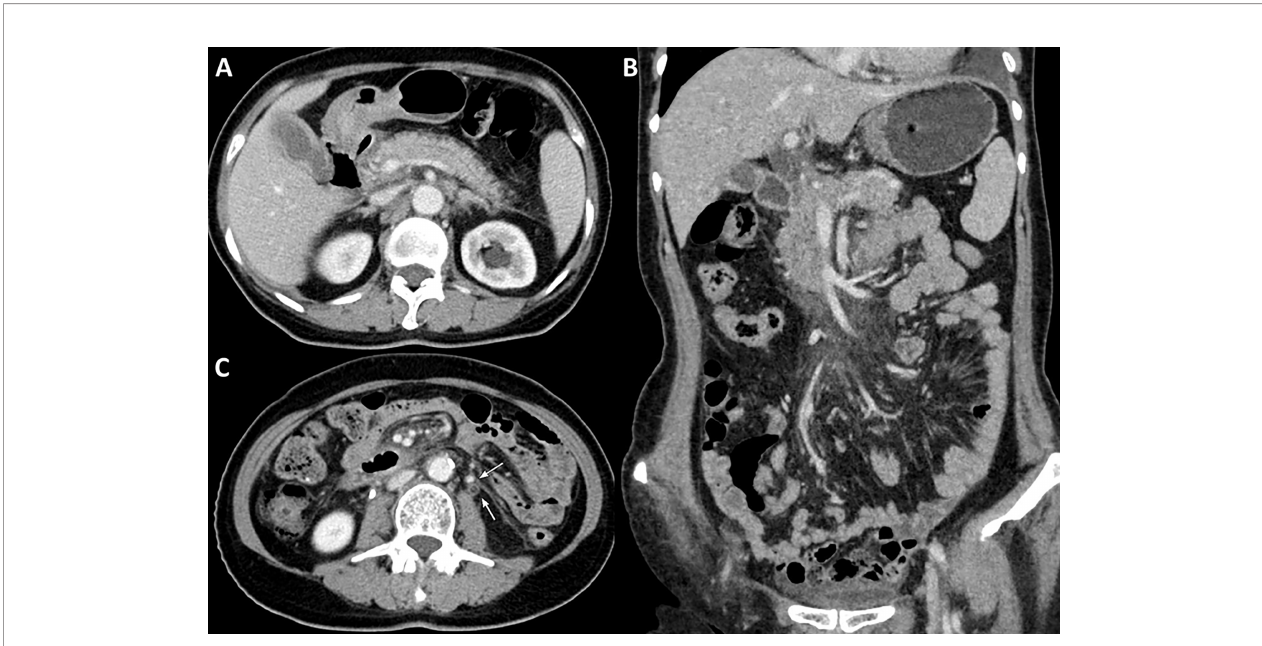
FIGURE 1 | Contrast-enhanced abdominal CT. (A) Contrast-enhanced CT reveals exudation around the pancreas and slight dilatation of the pancreatic duct, (B) a thickened peritoneum and cloudy mesentery, and (C) avid enhancement with accompanying ureterectasia (white